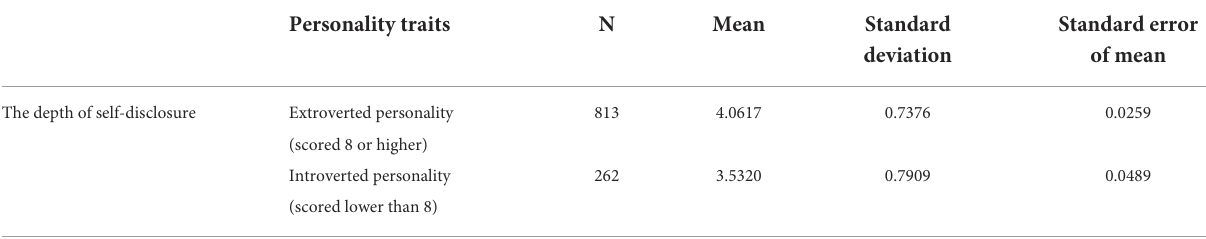
TABLE 7 Group statistics of different personality traits.